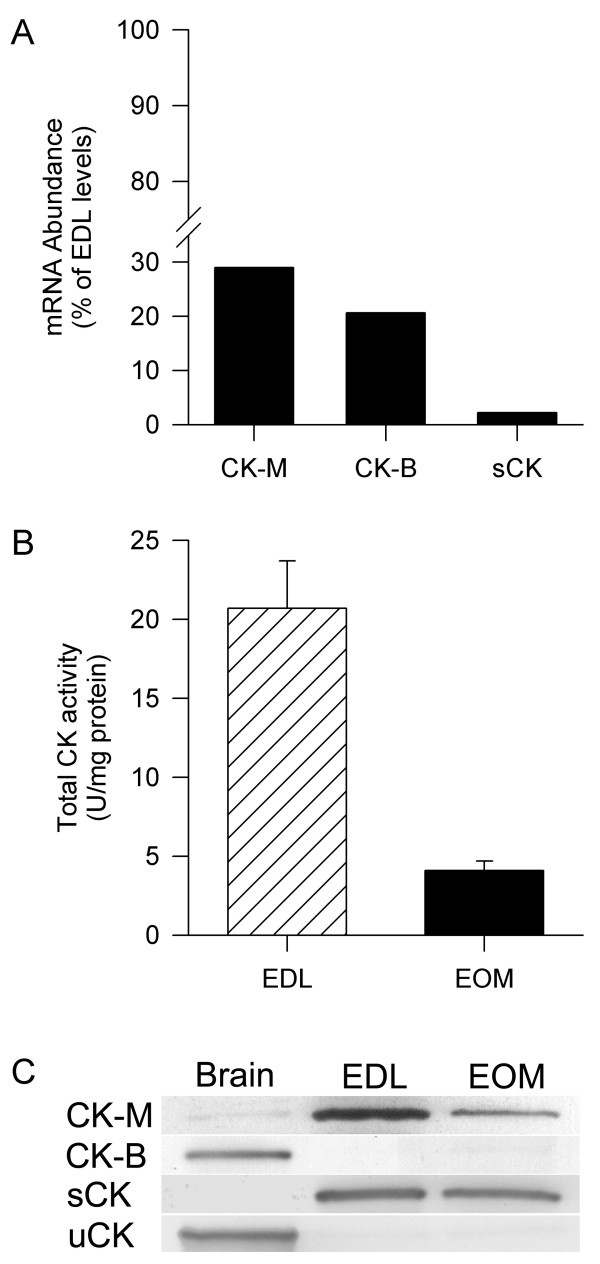
Lower CK isoform expression and activity in rat extraocular muscle. (A) Relative abundance of three CK isoform mRNAs in EDL and extraocular muscle by quantitative PCR. Each sample includes pooled muscles from 4 rats. Data are means from 3–4 samples, and are normalized to levels measured in EDL = 100%. Message levels for the cytosolic CK-M and CK-B, and the mitochondrial sCK were much lower in extraocular muscles compared to EDL. (B) Total CK activity in EDL and extraocular muscles. EDL muscles have ~5-fold greater CK activity than extraocular muscles (n = 8, P < 0.001). (C) CK protein isoforms found in brain, EDL and extraocular muscle by western blot.